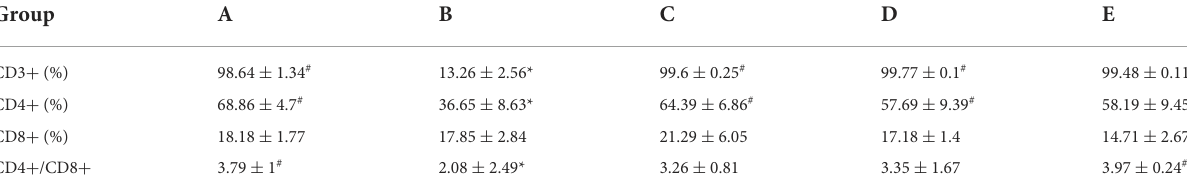
TABLE 2 Effects of CSPCM on CD4 + cells, CD8 + cells, and CD4 + /CD8 + in mesenteric lymph